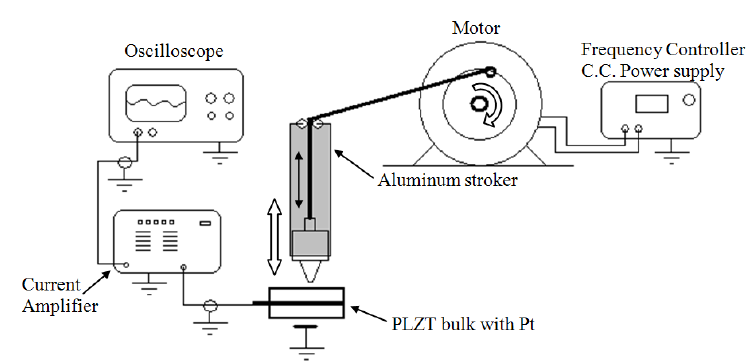
Figure 6. Mechanical setup to get the sensibility on the CCP selected